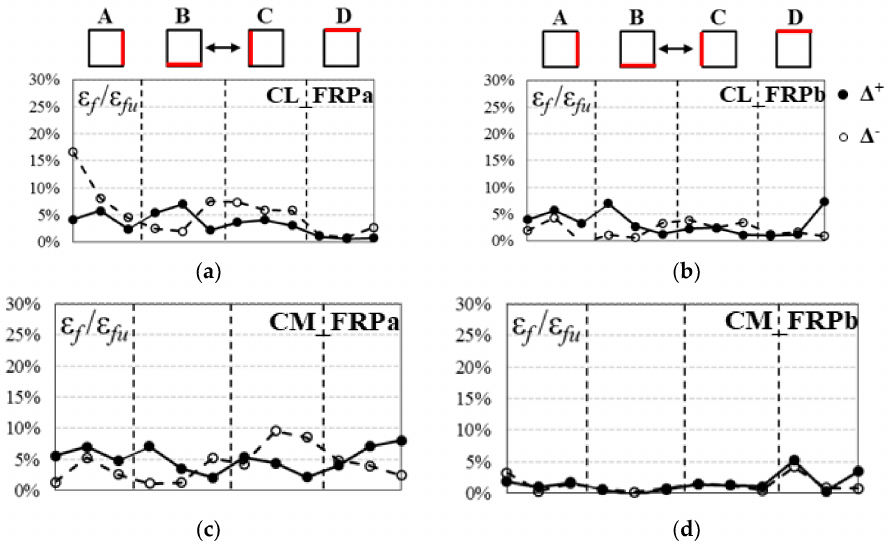
Figure 14. Horizontal CFRP axial strain profiles at a drift ratio of 6.4%: ( a ) CL_FRPa; ( b ) CL_FRPb; ( c ) CM_FRPa; ( d )